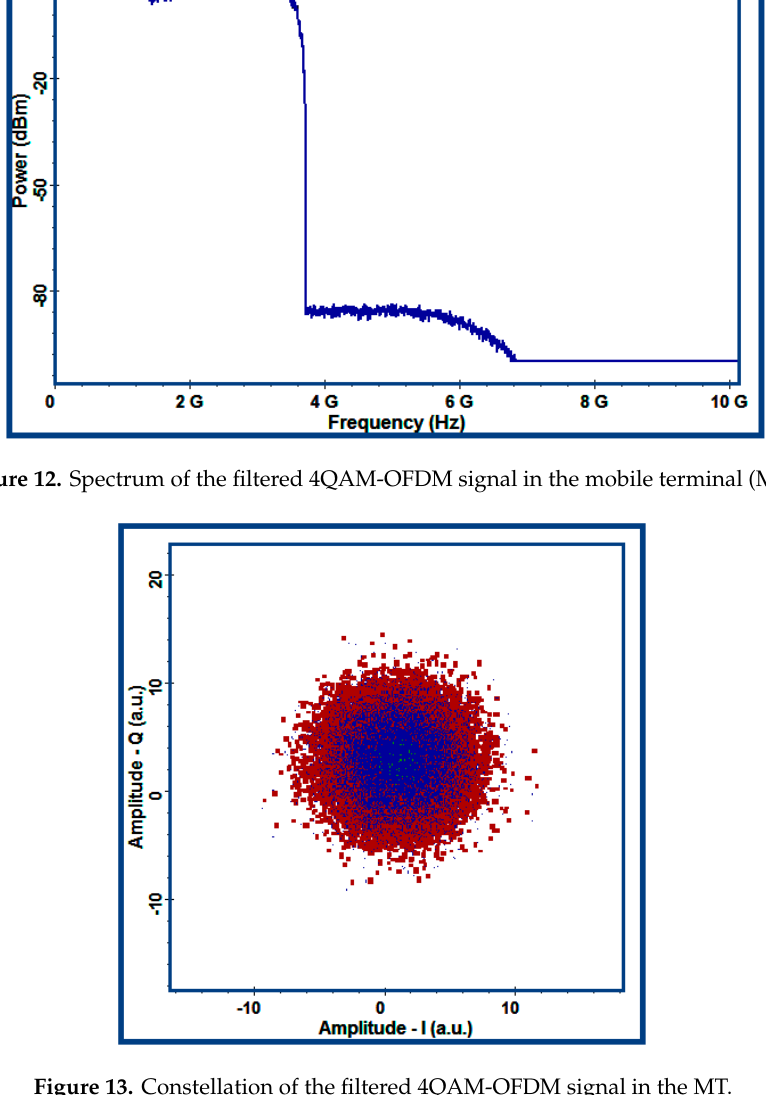
Figure 14. Original constellation of 4QAM signals in the CS.